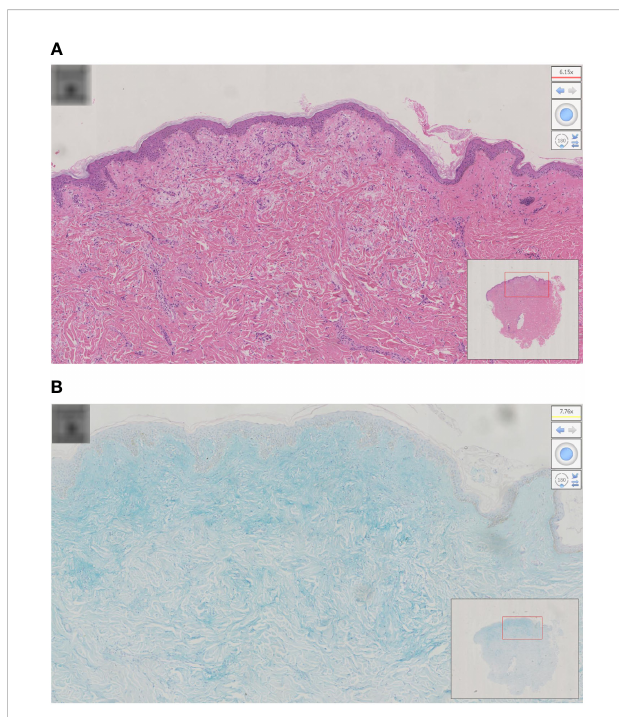
FIGURE 2 (A) Histopathology of scleromyxedema with the typical triad of mucin, fi broblast proliferation, and fi brosis; (B) alcian blue staining was positive in the upper and mid